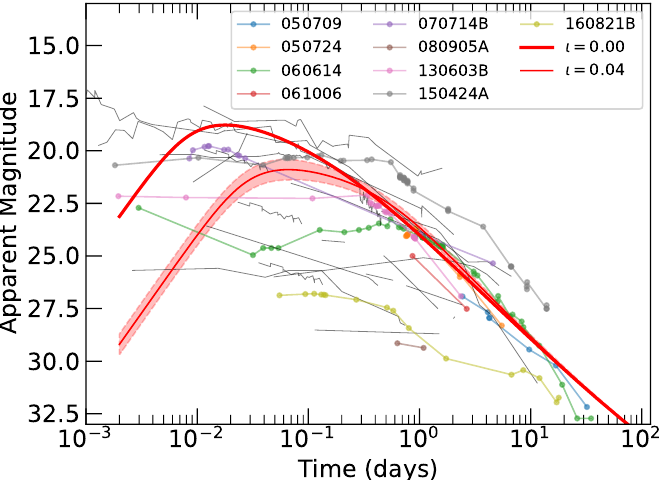
Figure 6. The averaged model afterglow lightcurve range for observers within the γ -ray bright angle, θ γ ; red lines indicate the afterglow viewed at an inclination ι = 0, and the widest angle for γ -ray emission, where the shaded region includes the maximum variability in peak flux expected due to the rotational orientation of the jet. The short GRB afterglows within our sample are shown as thin grey lines, and coloured lines with points marking data for short GRBs with candidate kilonovae. All lightcurves have been normalised to a redshift, z = 1, for consistency. Whereas the model lightcurves have a fixed ambient medium, n = 1cm − 3 , much of the diversity in the observed short GRB afterglows can be accounted for by varying ambient medium density values between events. This suggests that the intrinsic energy distribution of short GRB jets is quite narrow with environmental effects determining much of the population